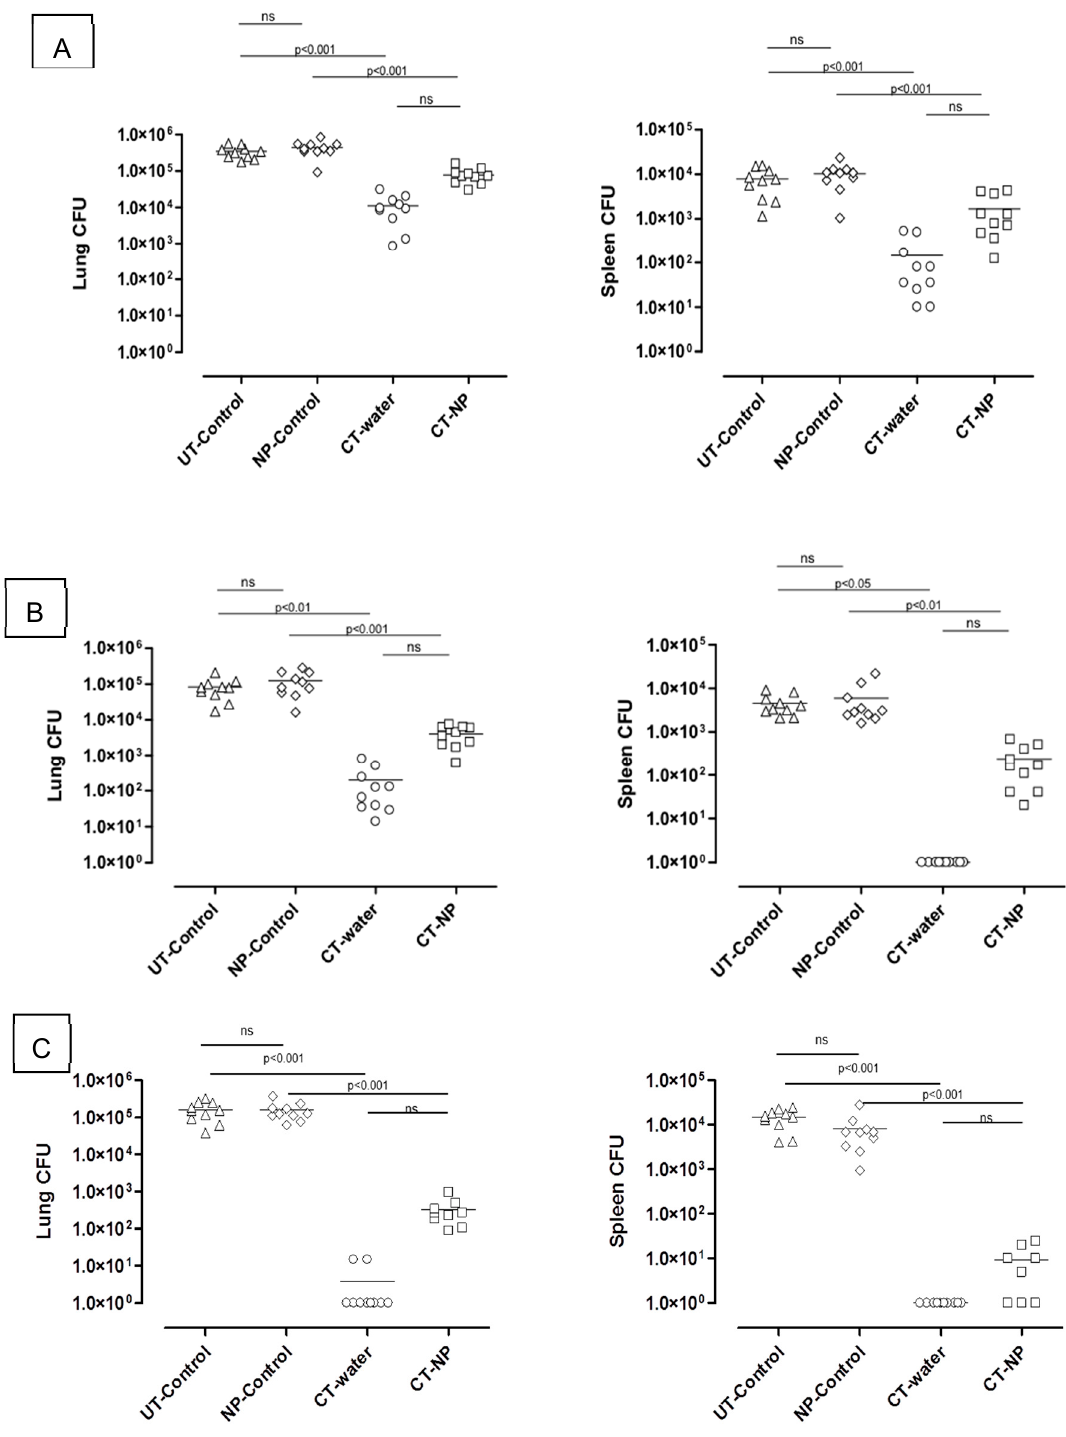
Figure 3. Bactericidal efficacy kinetics of treatment delivered in lungs and spleen of mice after ( A ) four, ( B ) six, and ( C ) nine weeks treatment period with encapsulated and unencapsulated INH/RIF/PZA (ns: not statistically significant).